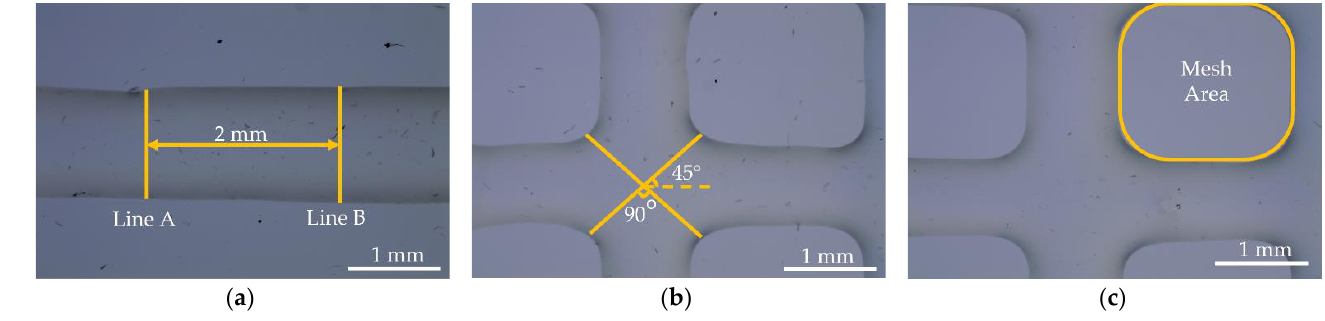
Figure 2. Measurement of ( a ) filament diameter, ( b ) merged filament size, ( c ) and mesh area.